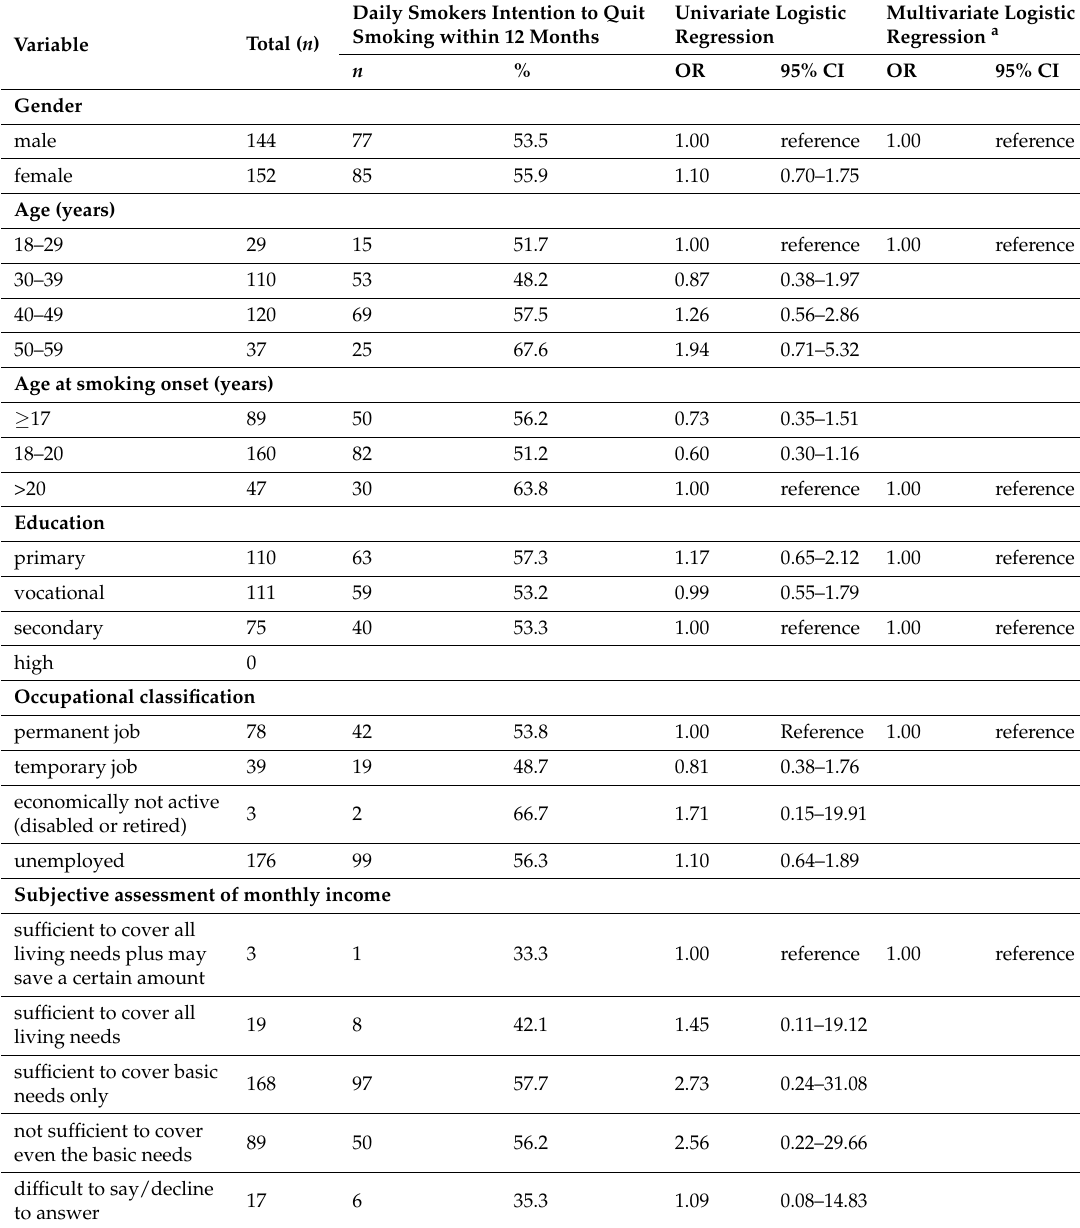
Table 5. Odds Ratios (OR) and 95% Confidence Intervals (CI) for the intention to quit smoking within 12 months to selected socio-demographic characteristics in men and women - current daily smoking from the Piotrkowski